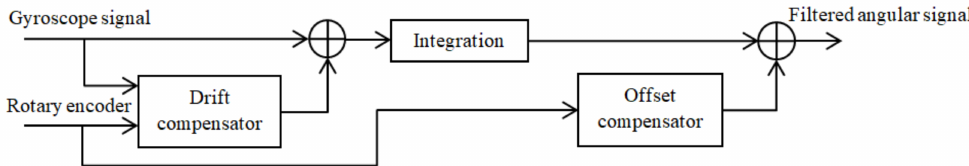
Figure 10. Structure of the